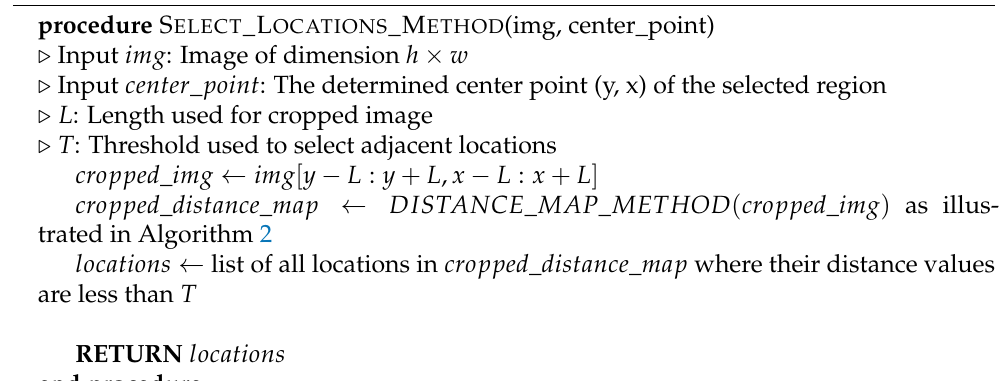
Algorithm 4 Select adjacent locations from the distance map for mutation